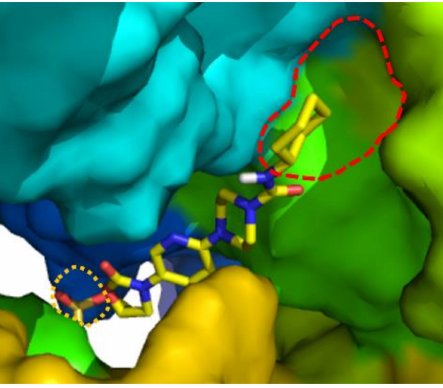
Figure 4. Binding pocket of compound 12b with the 50S ribosomal subunit.